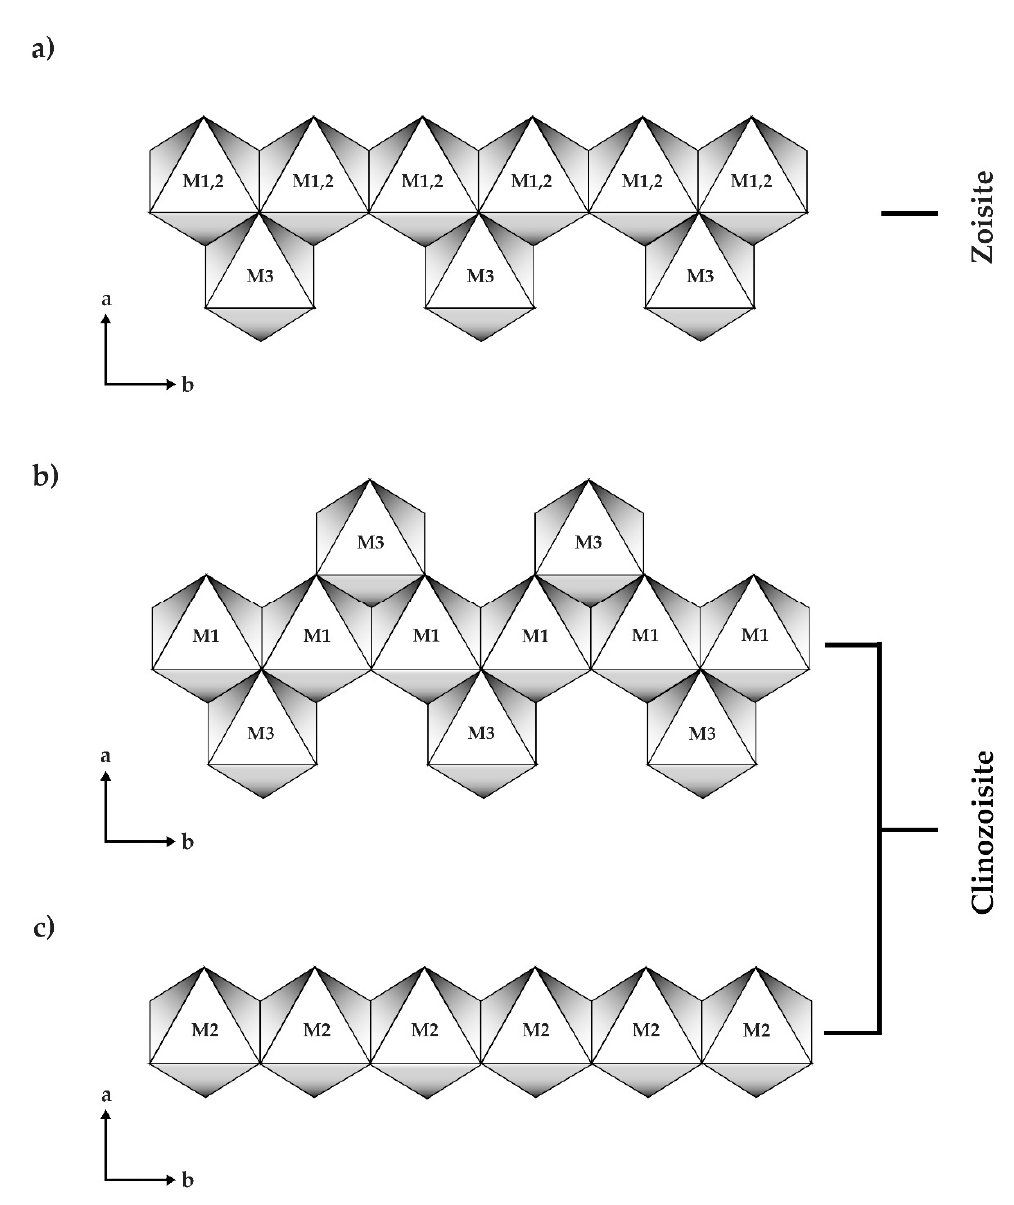
Figure 2. ( a ) Zoisite octahedral chain (M1, 2) combined with additional octahedra (M3) on only one side along b-direction, whereas ( b ) additional octahedra (M3) located on both sides of clinozoisite octahedral chain (M1) with ( c ) isolated octahedral chain (M2) (modified after Franz and Liebscher [7]).